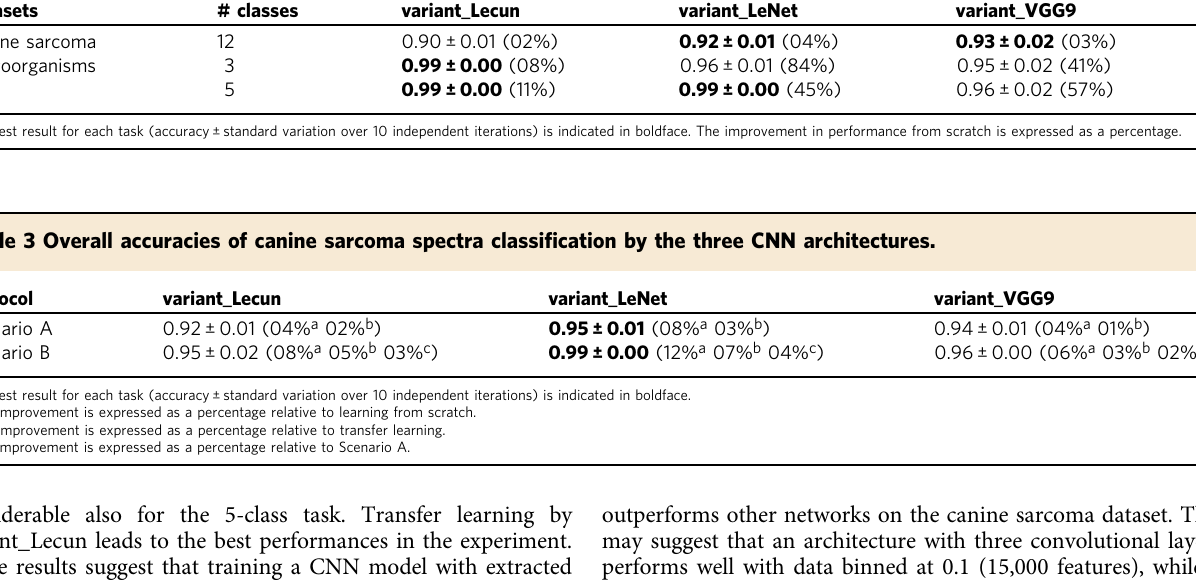
Table 2 Overall accuracies of SpiderMass spectra classi fi cation using three CNN architectures after transfer learning. Datasets